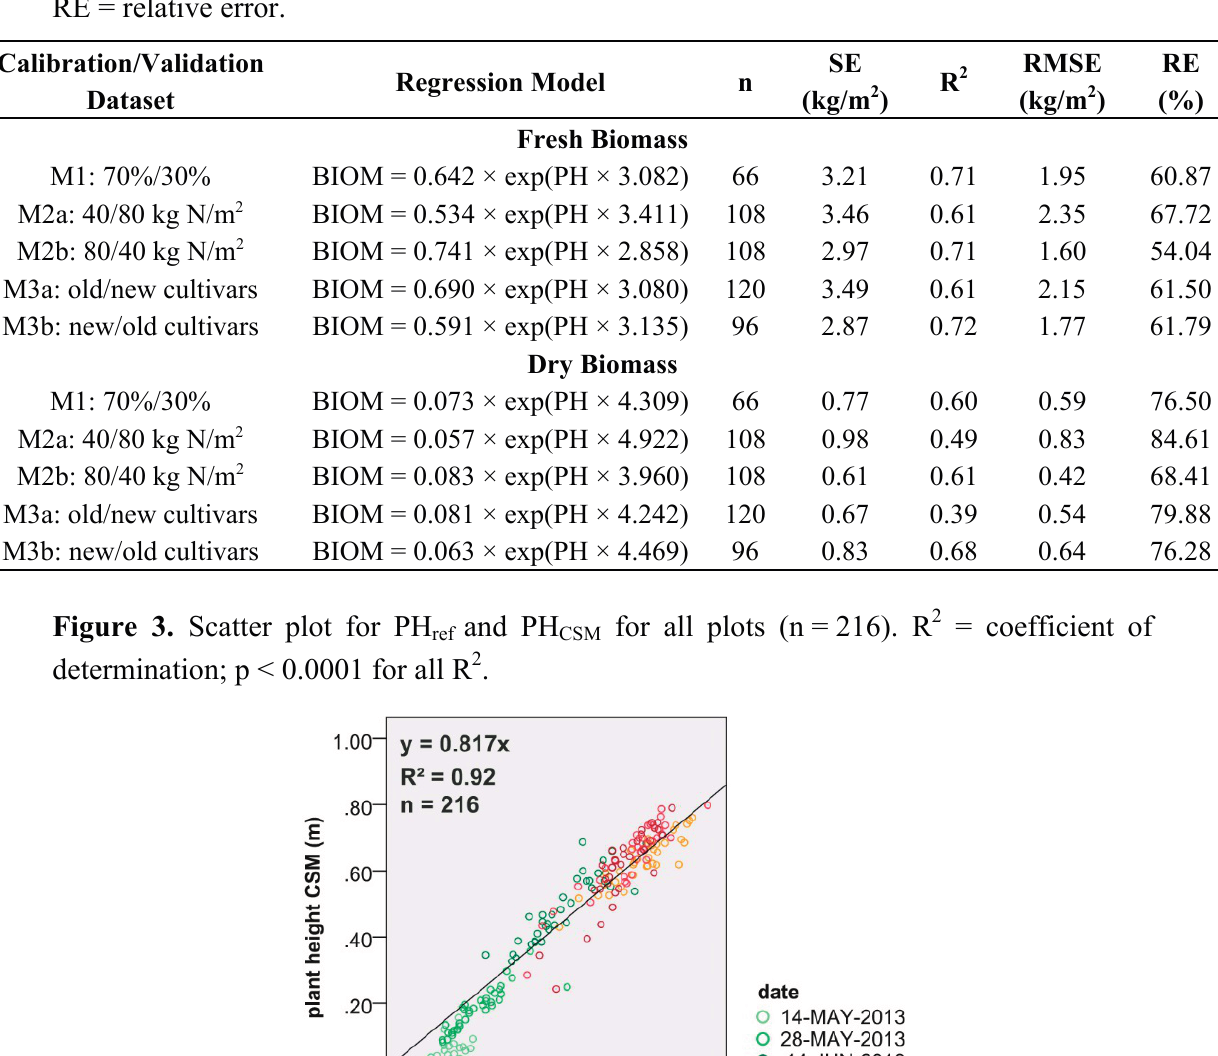
Table 4. Regression characteristics of observed versus predicted biomass. M1: 70% calibration, 30% validation; M2a: model for 40 kg N/m 2 applied on plots treated with 80 kg N/m 2 ; M2b: model for 80 kg N/m 2 applied on plots treated with 40 kg N/m 2 ; M3a: model for old cultivars applied on new cultivars; M3b: model of new cultivars applied on old cultivars. n = sample number of validation dataset; SE = standard error; R 2 = coefficient of determination; with p < 0.0001; RMSE = root mean square error;